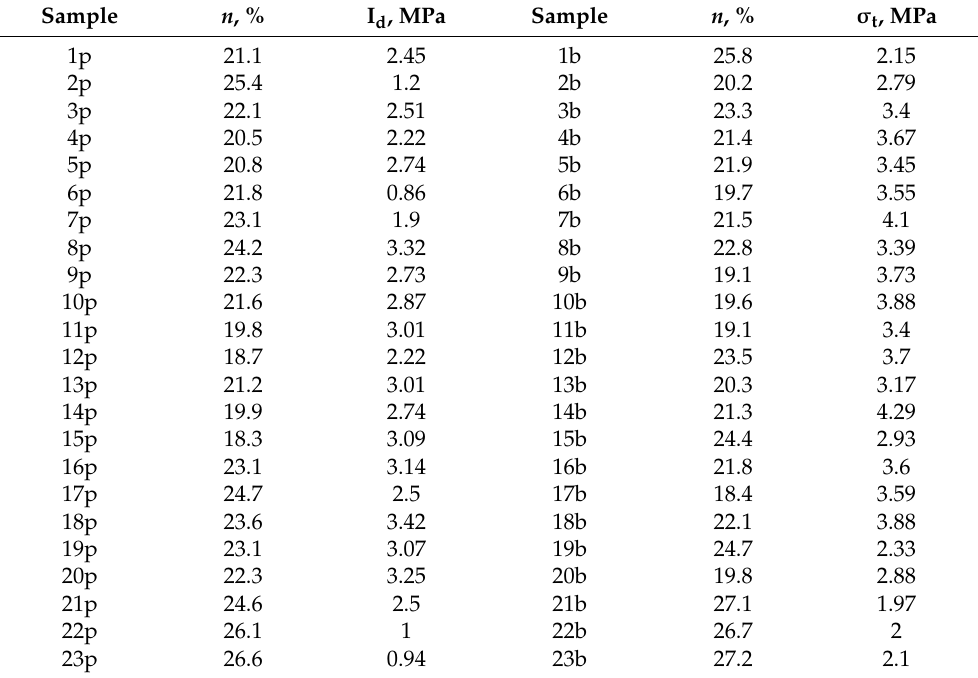
Table 5. Point load index (I d ) and indirect (Brazilian) tensile strength ( σ t ) of the zeolite-bearing rocks.